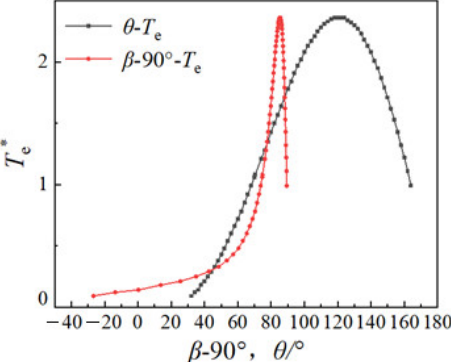
Figure 18. The curve of per unit value of torque at λ = 0.8 ρ = 7.